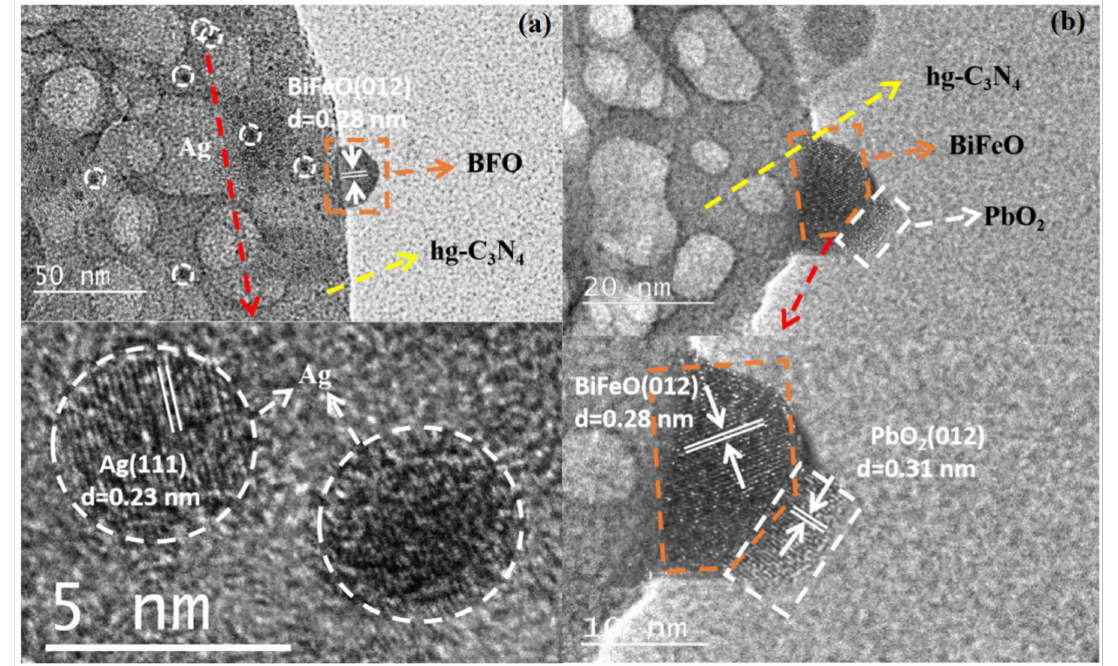
Figure 12. HRTEM images of ( a ) Ag and ( b ) PbO 2 photo deposited in the existence of a BiFeO/hg- C 3 N 4 sample, respectively.